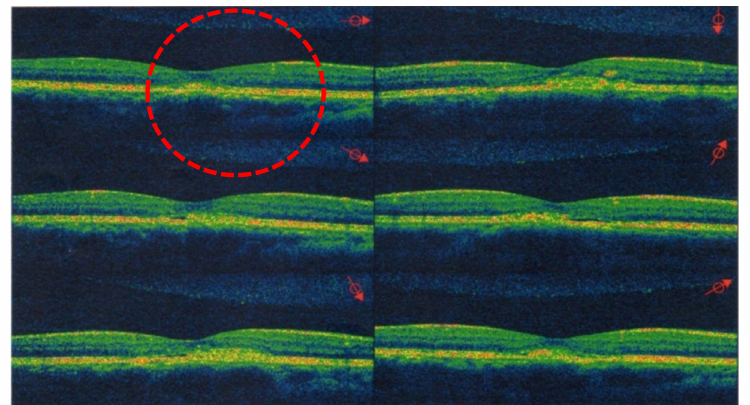
Figure 2. Optical coherence tomography (OCT) images generated using the OPKO (E-Vision Instrument Company, Taiwan) in a 42-year-old male with CSCR. The topographic maps show highly bulged swelling from macular retinal edema and loss of the fovea at day 1.